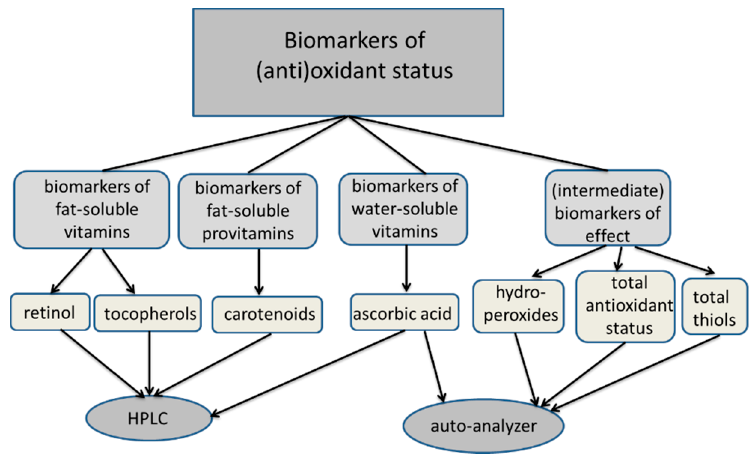
Figure 5. Proposed scheme for the measurement of biomarkers of (anti)oxidant status related to nutrition and chronic diseases in large-scale studies.